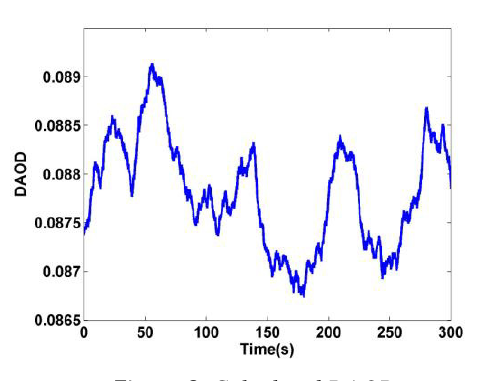
Figure 8 Calculated DAOD